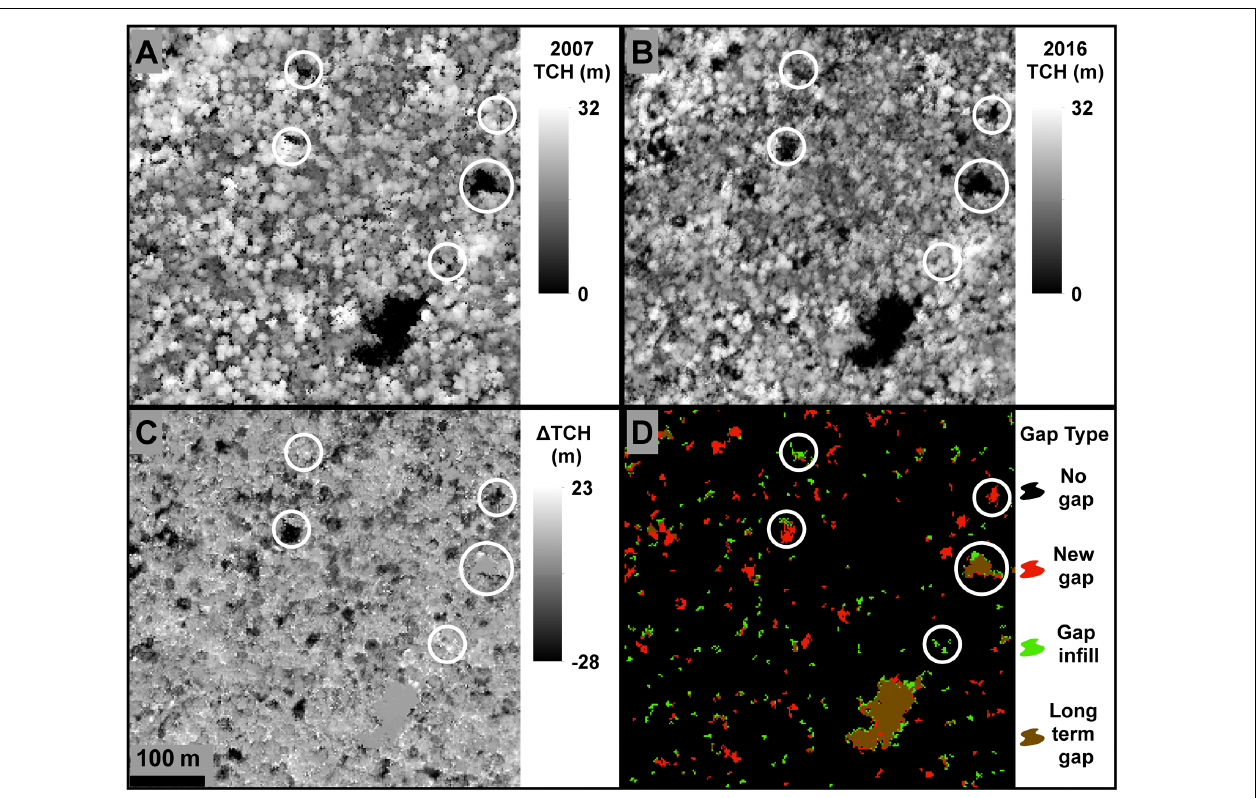
FIGURE 2 | Example results on changes in top-of-canopy height (TCH) and gaps, derived from airborne LiDAR. (A) TCH in 2007. (B) TCH in 2016. (C) Change in TCH between 2007 and 2016. (D) Gap dynamics from 2007 to 2016, showing newly formed gaps in red, filled gaps in green, and gaps that have persisted from before 2007 in brown.